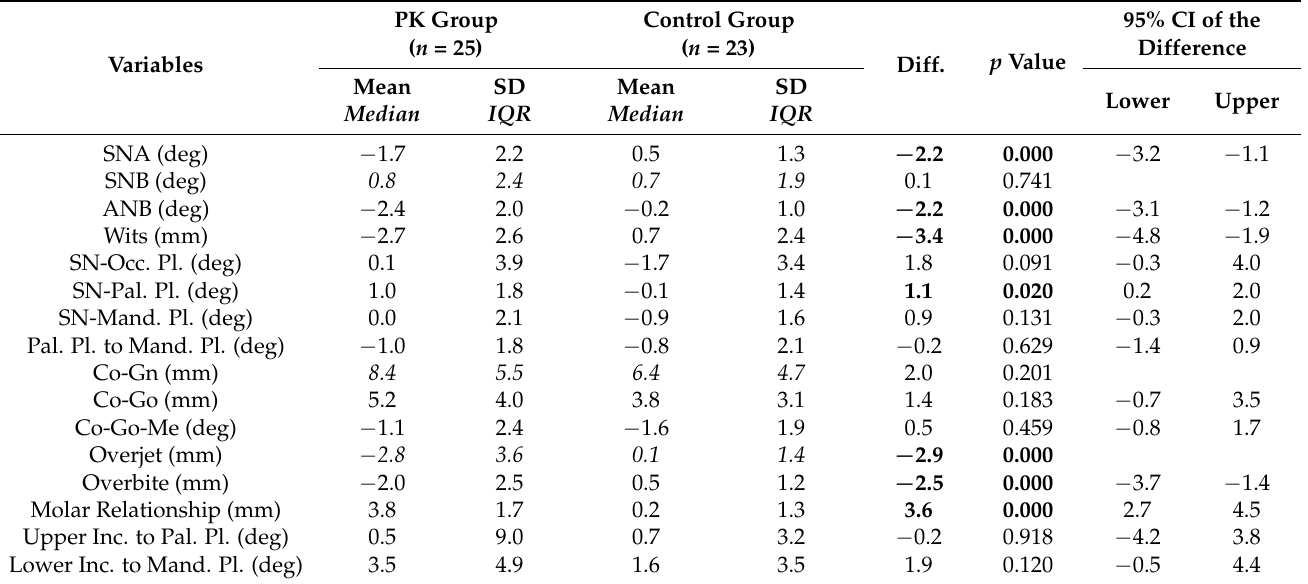
Table 3. Descriptive statistics and statistical comparisons (independent-samples t -test or Mann–Whitney U test) for the T1-T2